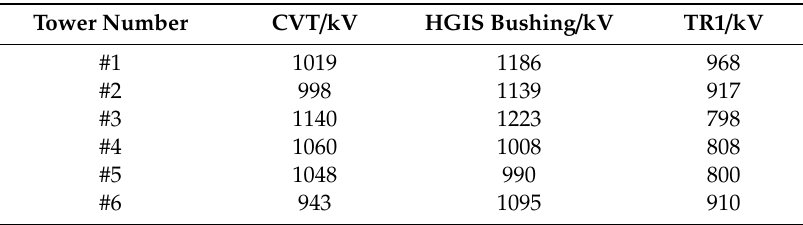
Table 7. Voltage of the equipment.